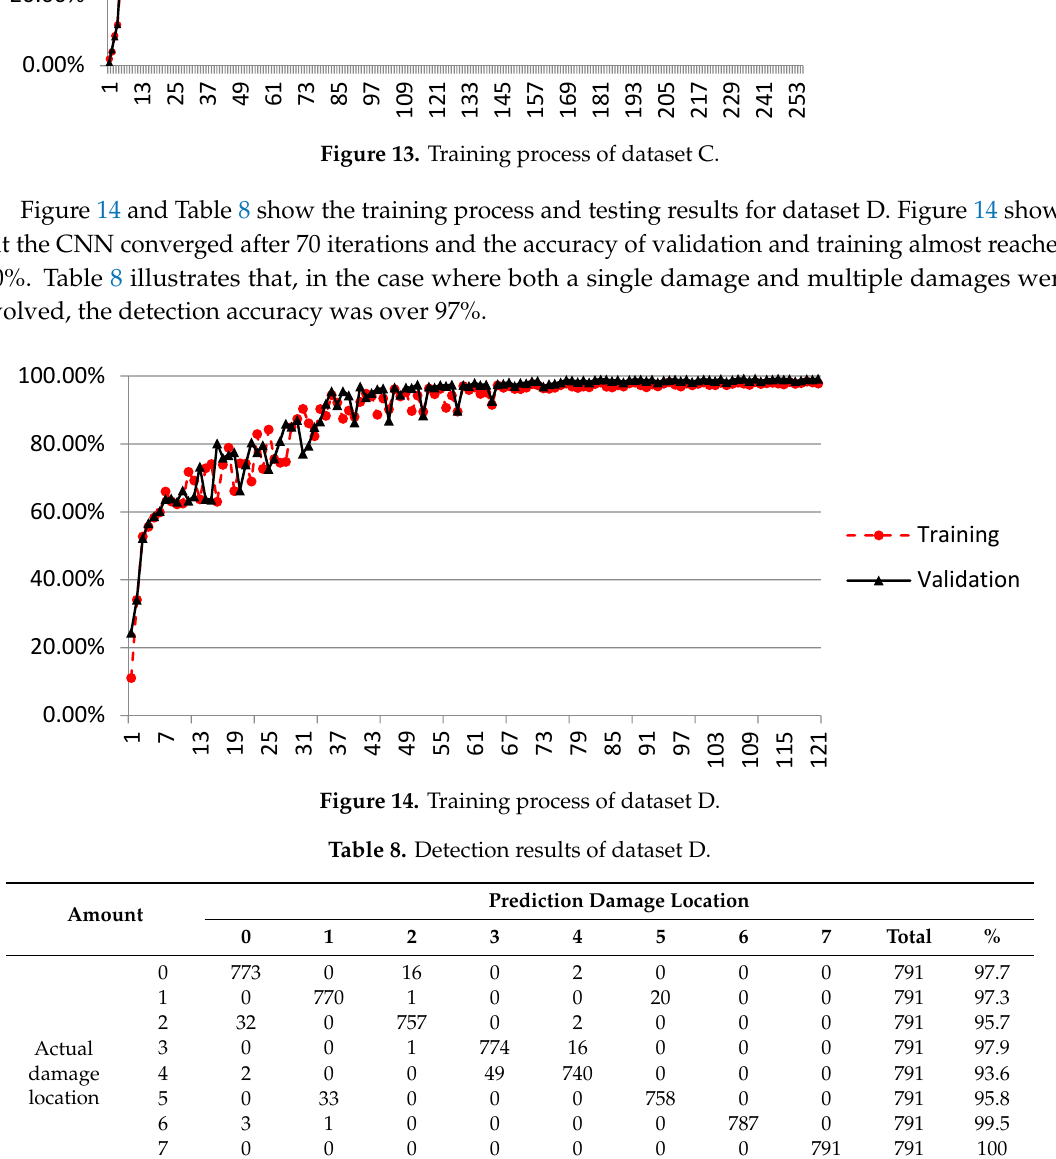
Table 8 is the testing results of damage detection for the experimental